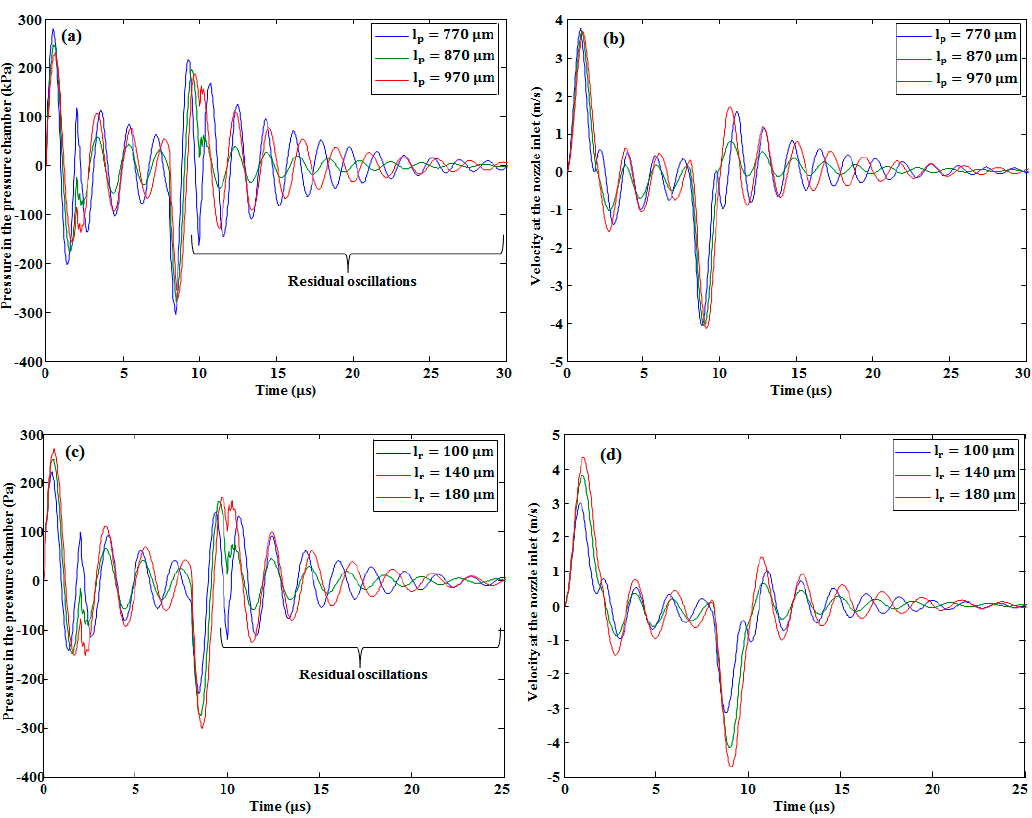
Figure 13. Effect of pressure chamber length variation on ( a ) pressure at the pressure chamber and ( b ) velocity at the nozzle inlet. Effect of restrictor length variation on ( c ) pressure and ( d ) velocity.